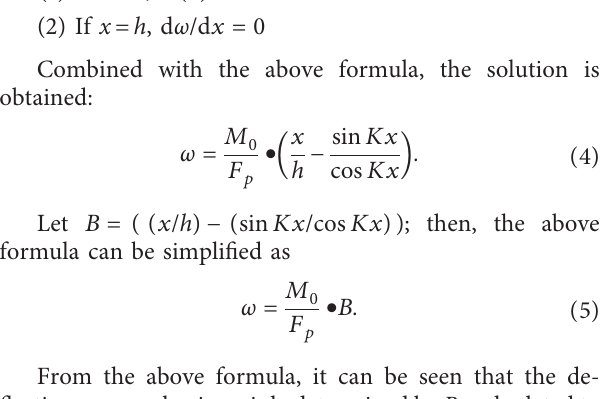
Figure 8: Variation curves of vertical stress inside the upper boundary of